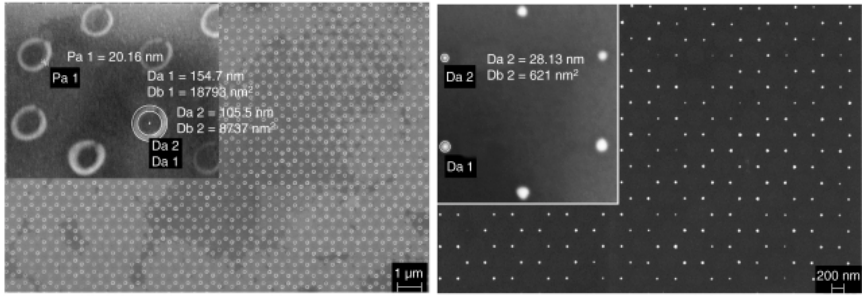
Figure 5. Making of non-closed packed polystyrene monolayer arrays by oxygen plasma etching under different etching conditions [45]. Scale bars: 200 nm, insets: 500